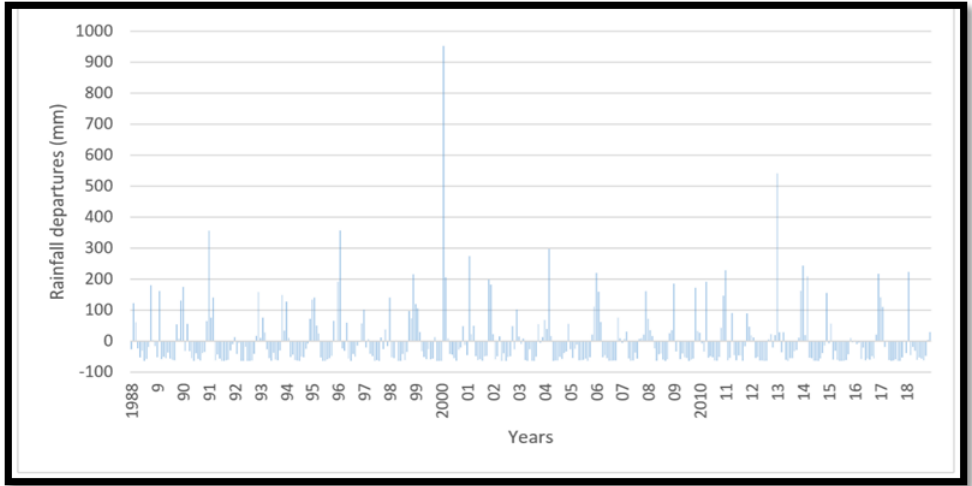
Figure 10. Rainfall departures of Thohoyandou area from 1988 to 2018.